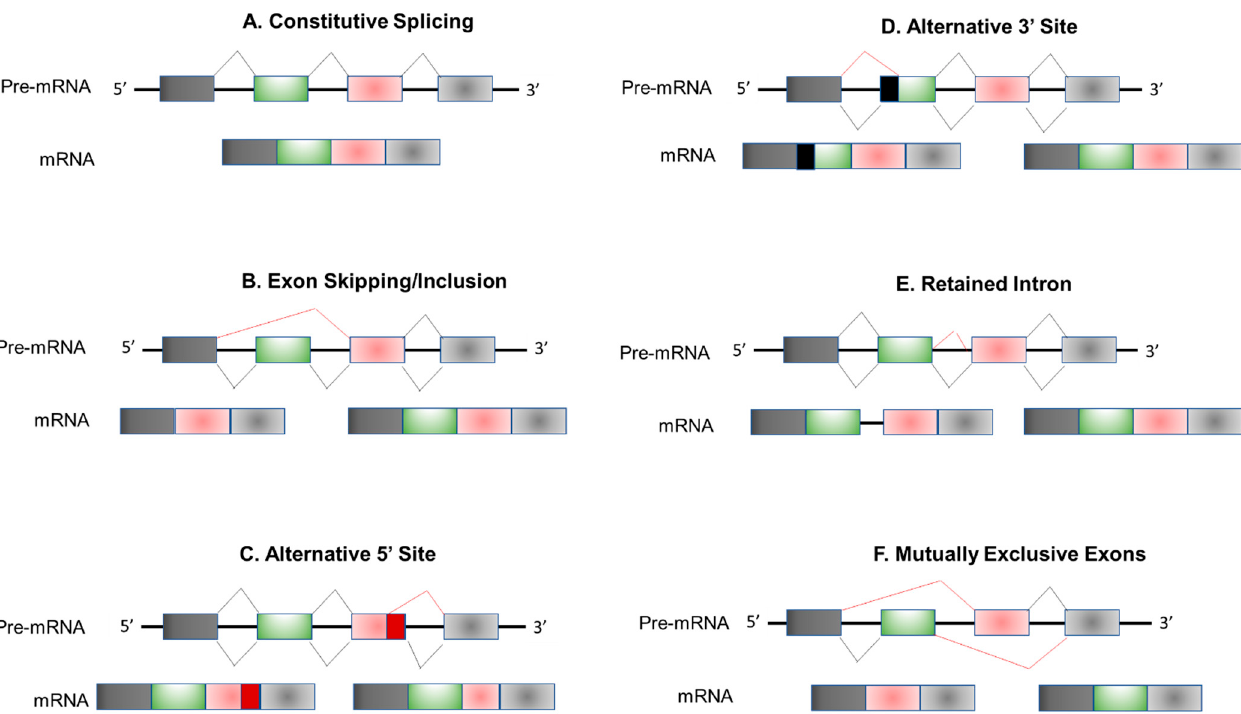
Figure 2. Schematic Representation of Most Common Alternative Splicing Pattern. ( A ) Constitutive splicing. ( B – F ) Alternative splicing modes. Skipped exon ( B ), alternative 5 ′ splice site selection ( C ), alternative 3 ′ splice site selection ( D ), retained intron ( E ), and mutually exclusive exon ( F ). Different colors represent difirrent exons.